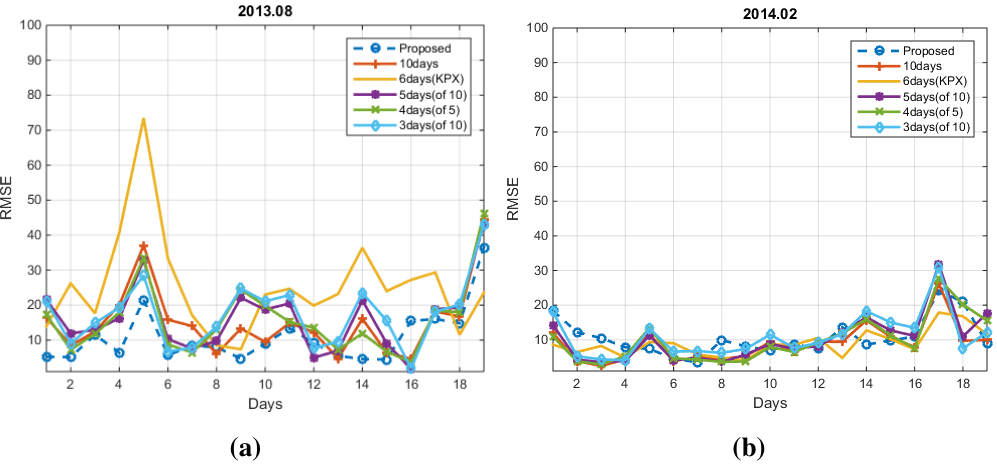
Figure 8. Root mean square error ( RMSE ) evaluation of site A in summer season ( a ) and winter season ( b ).